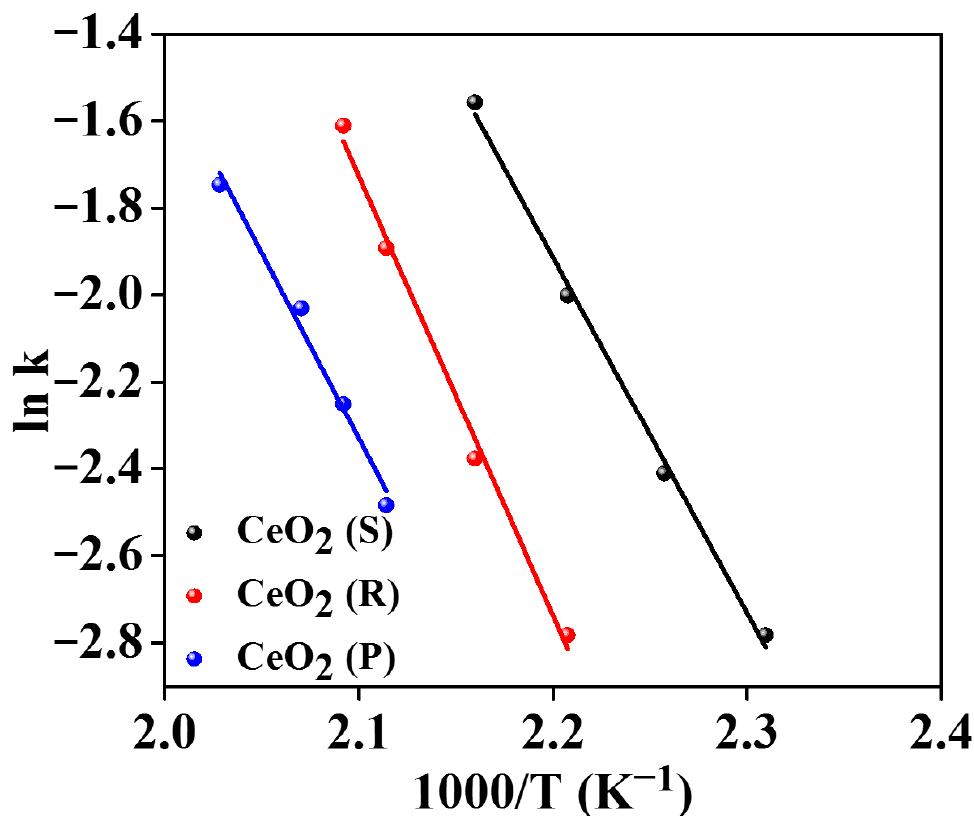
Figure 8. Arrhenius plot for toluene oxidation over CeO 2 (S), CeO 2 (R), and CeO 2 (P). Table 3. Catalytic oxidation of toluene over different morphologies catalyst.